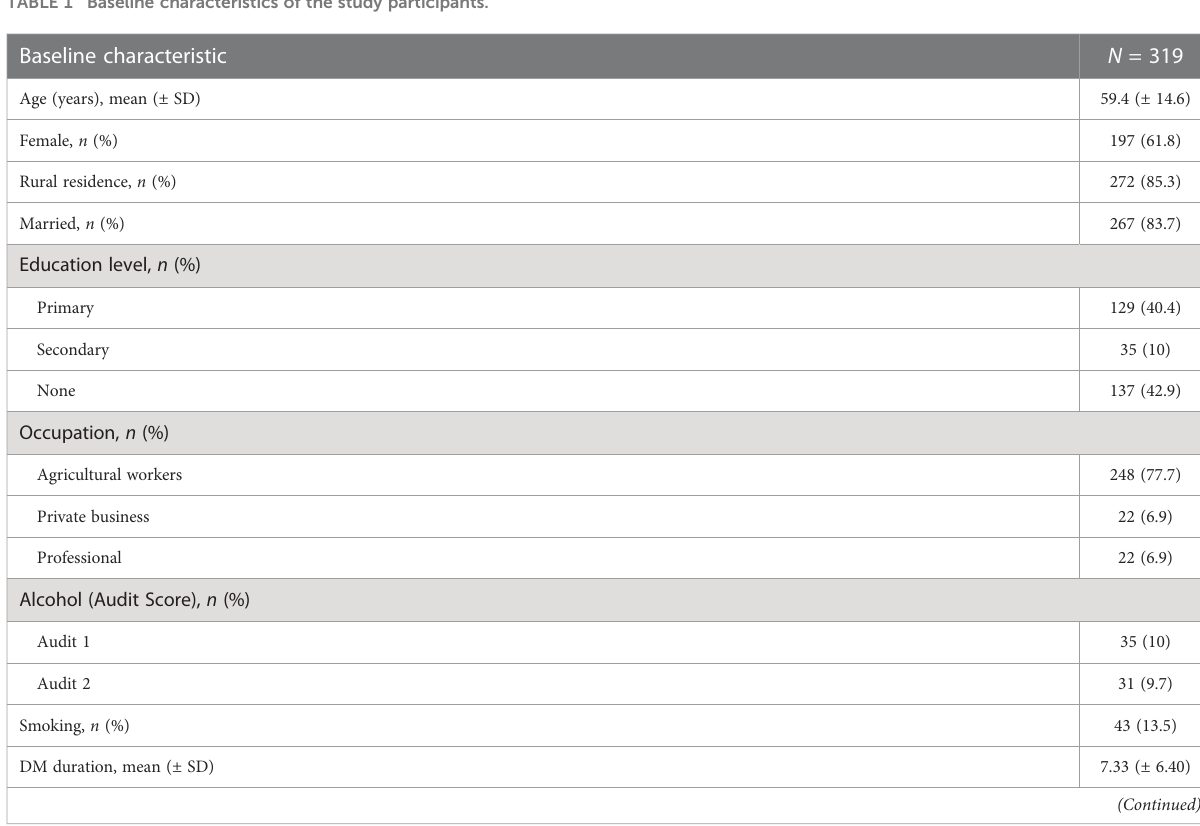
TABLE 1 Baseline characteristics of the study